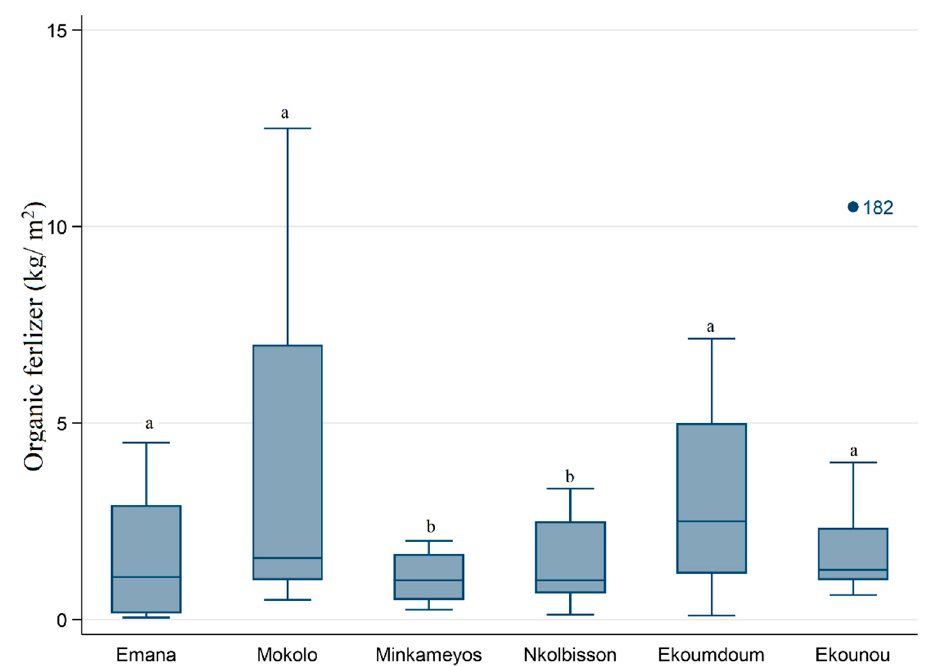
Figure 5. Box plot showing the distribution of the amount of organic fertilizer used per m 2 in the studied areas. (Same letters indicate no significant differences at p < 0.05; data are shown using box whisker plot to reveal the heteroscedasticity; the significance indicator refers to a robust generalized linear model).